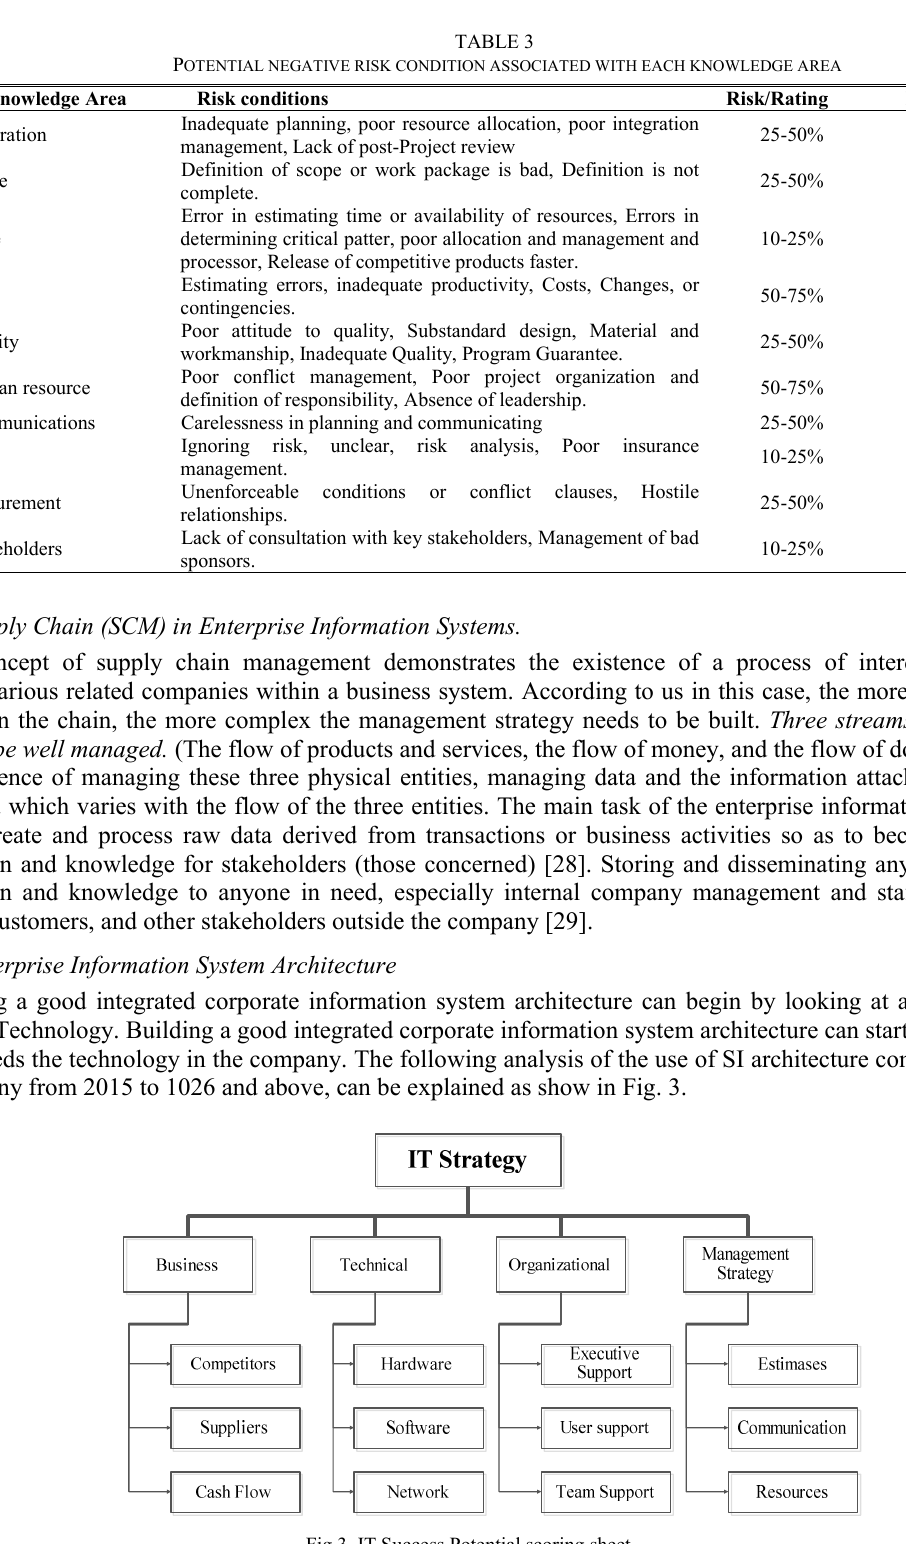
Fig 3. IT Success Potential scoring sheet.